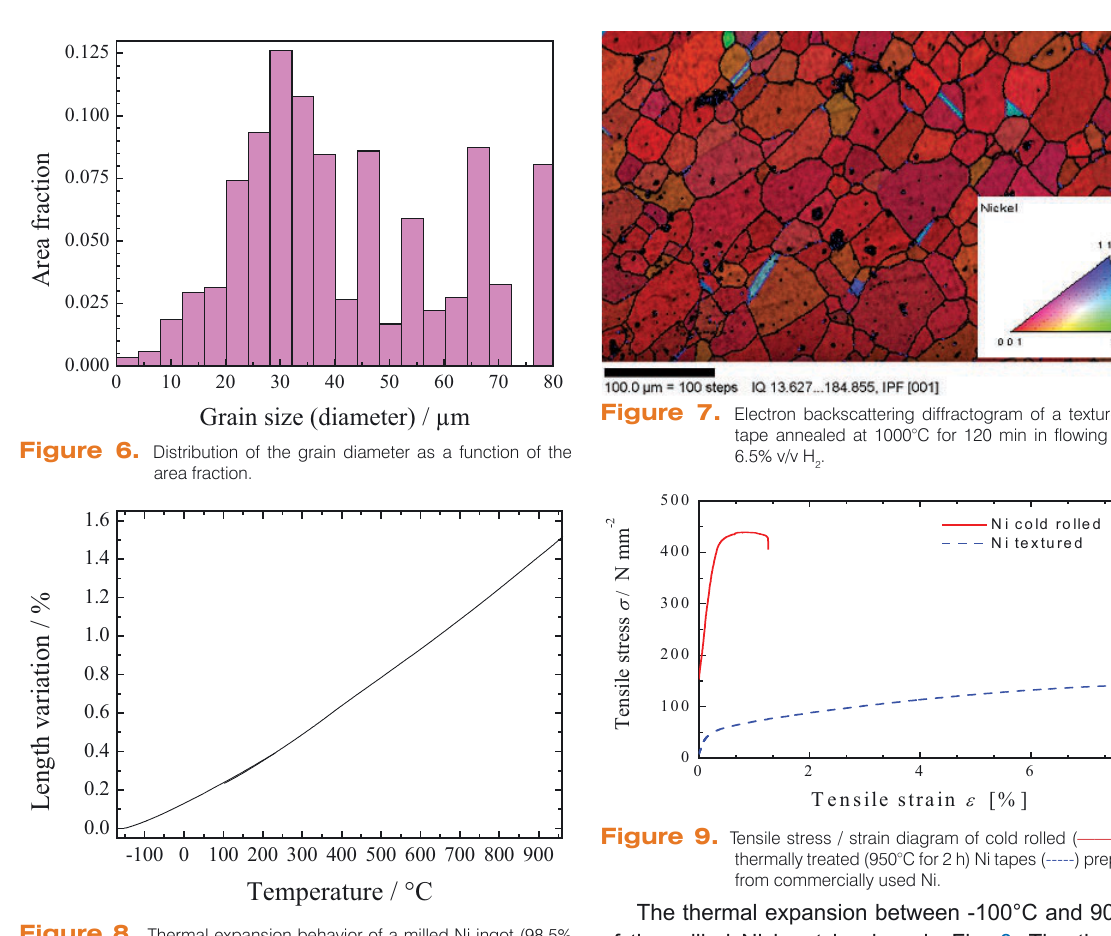
Figure 8. Thermal expansion behavior of a milled Ni ingot (98.5% Ni).